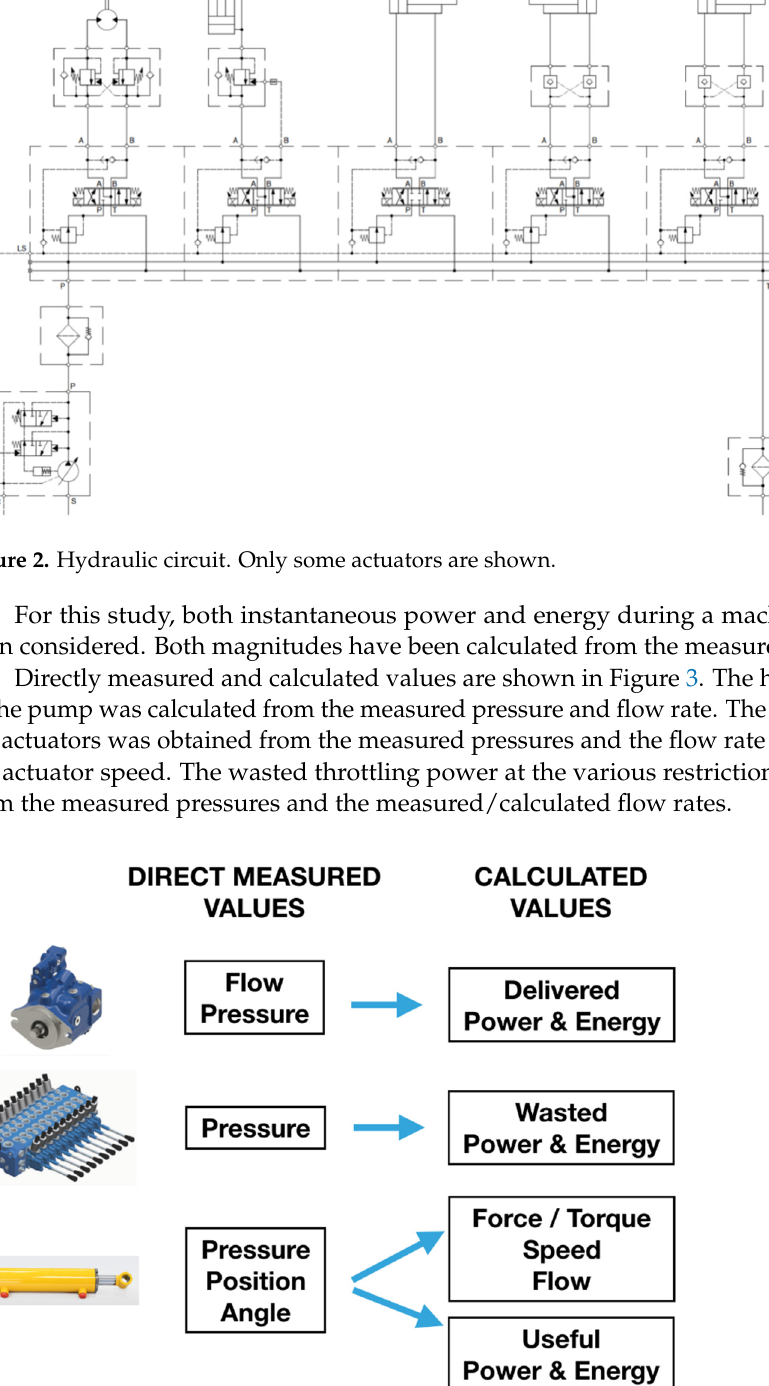
Figure 3. Direct measured and calculated values.